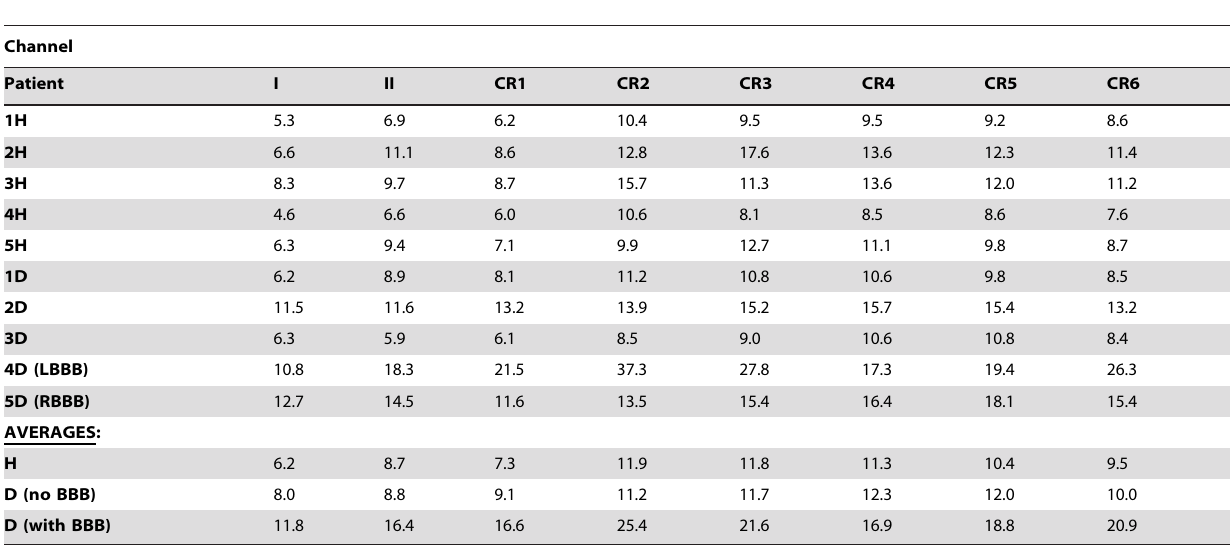
RMS: Root mean square, with RMS difference values expressed in analog to digital converter (ADC) counts, and with 1 ADC count=2.44 m V. Channel: the equivalent of leads I, II and the precordial electrodes as referenced to the right arm electrode (CR1-CR6). H and D: Healthy and Diseased patients, respectively. LBBB and RBBB: left and right bundle branch block (BBB), respectively. doi:10.1371/journal.pone.0061076.t001 leg electrode input remaining as DAC common? Figure 1 expresses this problem graphically by showing a generalized functional diagram for a typical 12-lead ECG system, but ignoring (as defined) the non-independent leads III, aVR, aVL and aVF. Table 2. RMS difference values for all 10 patients’ original versus re-digitized files when the original files were collected on a Cardiax ADC and the re-digitized files on a CorScience